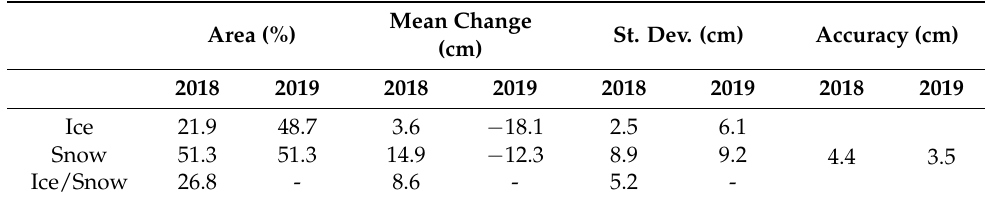
Table 3. Difference of digital elevation models (DEMs) that show the extents (%) and statistics (means and standard deviations) of accretions (positive values) and sublimation (negative values) of the different surface types during the month of December 2018 (B–C) and between 2018 and 2019 (C–D). The accuracy indicates the propagation of errors during the differencing. Mean Change Area (%) St. Dev. (cm) (cm)